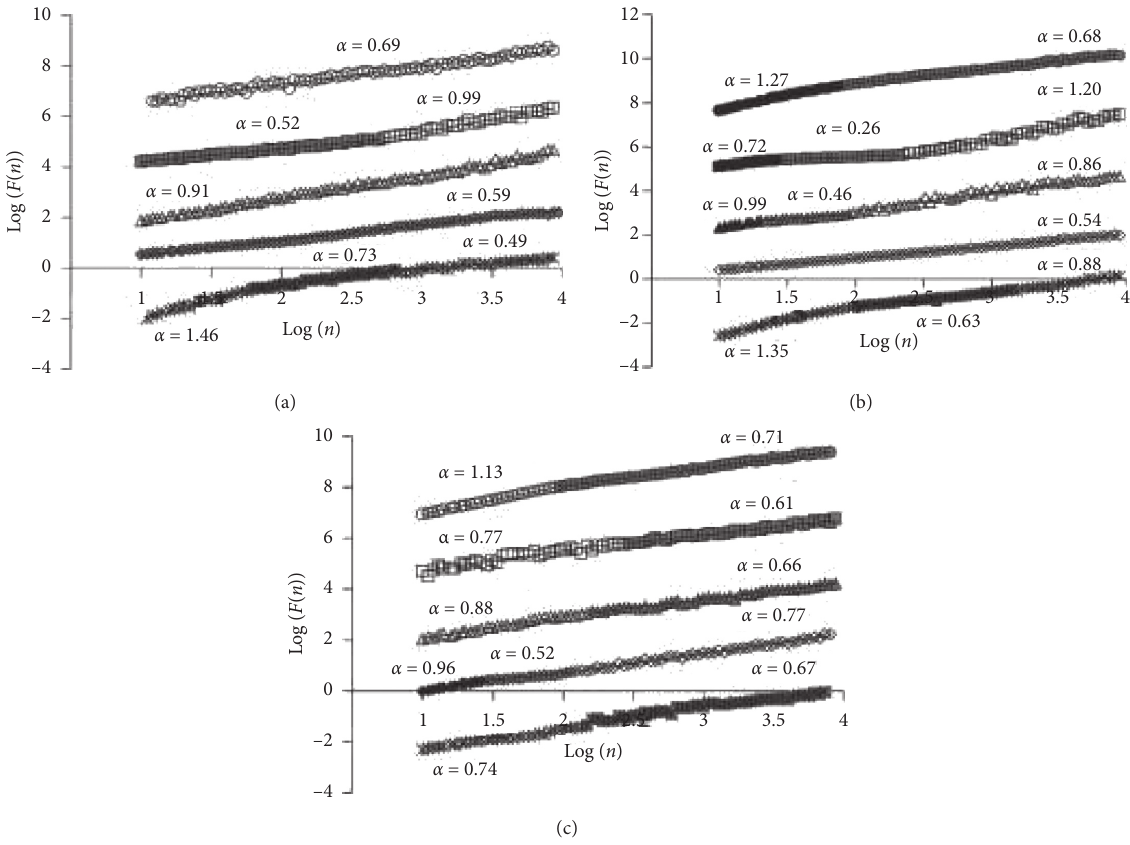
Figure 1: DFA p � 2, fluctuation curves of RTTtime series for first (a), second (b), and third (c) days, day-time measurements. From top to bottom measurements for GTU, Harvard, UCLA, USC, and USTC